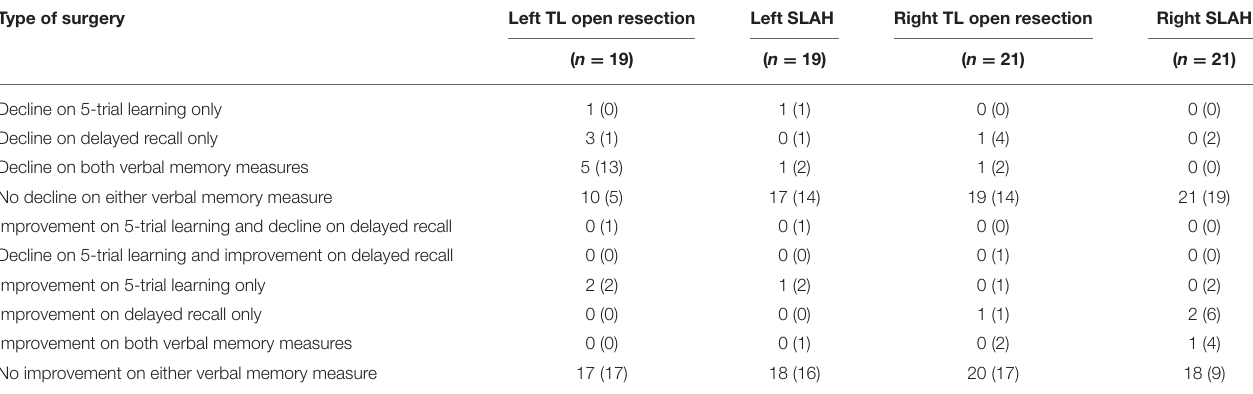
TABLE 3 | Patterns of verbal memory decline observed in open resection and SLAH based on both reliable change scores and single standard deviation methodologies. Type of